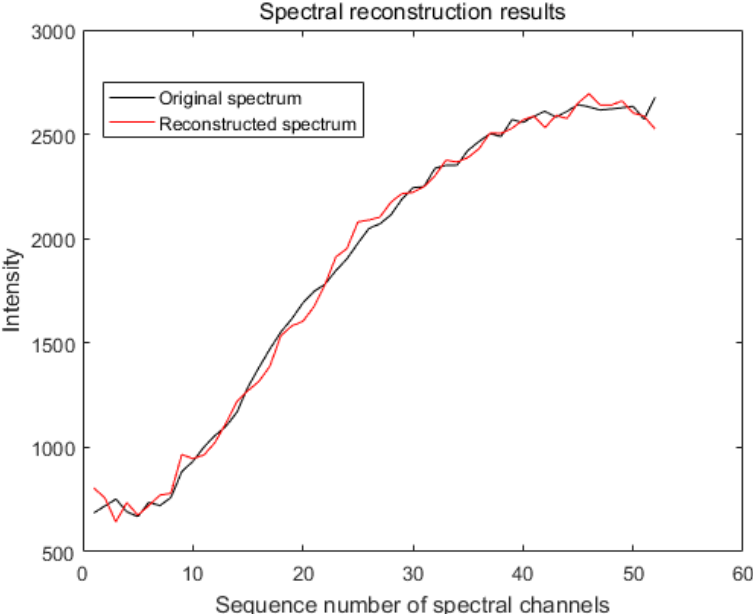
Figure 6. Original spectrum and reconstructed spectrum using the GCV-based Tikhonov algorithm (the mean squared error (MSE) is 6.8 × 10 − 4 and the relativistic spectral quadratic (RQE) is